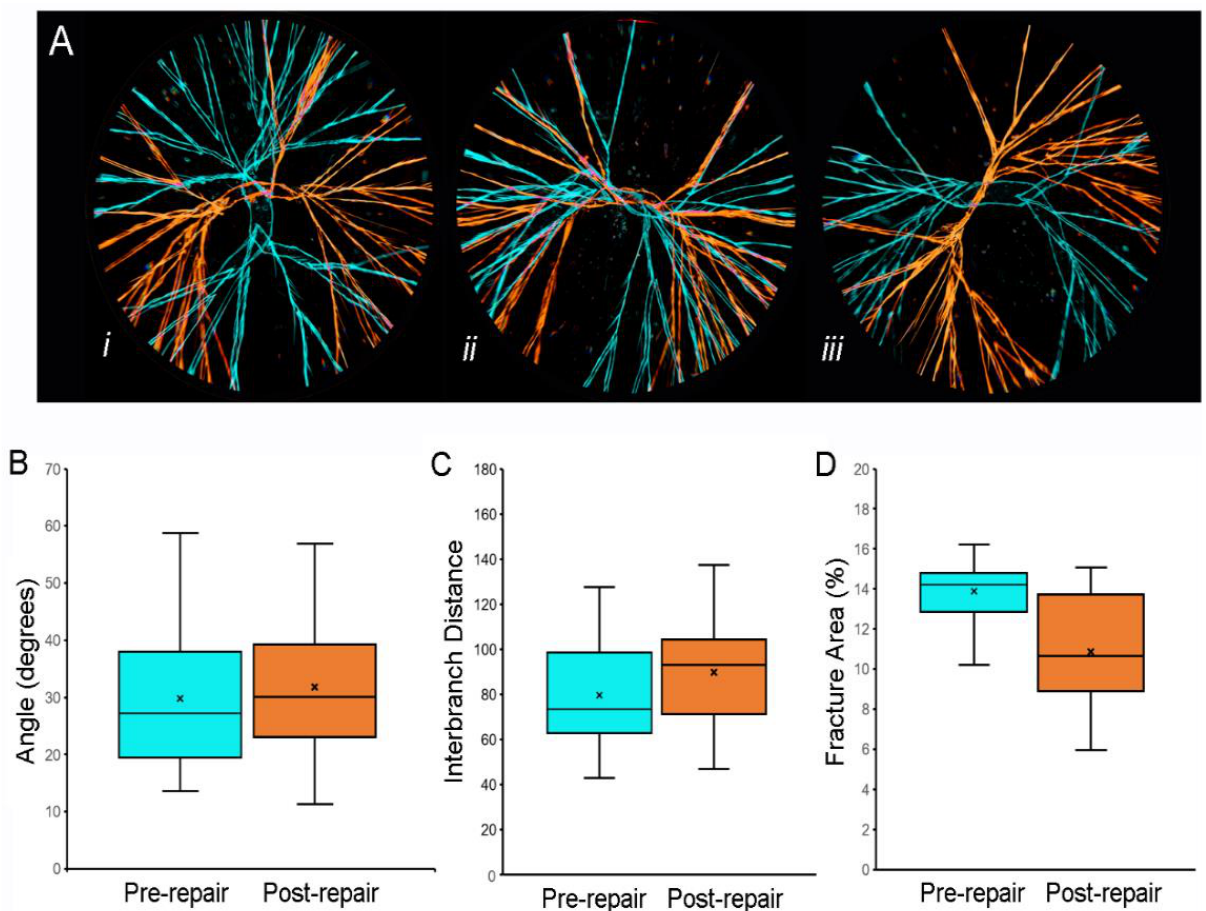
Figure 6. Fracture patterns of pectin films before and after water-induced repair. ( A ) Representative images of fracture patterns obtained before (blue) and after (orange) water-induced repair were thresholded and superimposed using the MetaMorph Stack Arithmetic Logical XOR function. Original orientation of the pectin films was maintained for comparison. The similar orientation of the fracture patterns in (A ii ) was the exception; in most films, the fracture patterns appeared to be randomly oriented (e.g., (A i ) and (A iii )). Morphometry of the fracture patterns demonstrated no significant difference in fracture angles ( B ), p > 0.05 or interbranch distance ( C ), p > 0.05. The total area of the pattern was slightly lower in the post-repair compared to the pre-repair fracture patterns ( C ), p < 0.05. In ( B – D ), the box spans the interquartile range with the median marked with an X and the whiskers defining the data range. A minimum of 10 3 features were measured for each